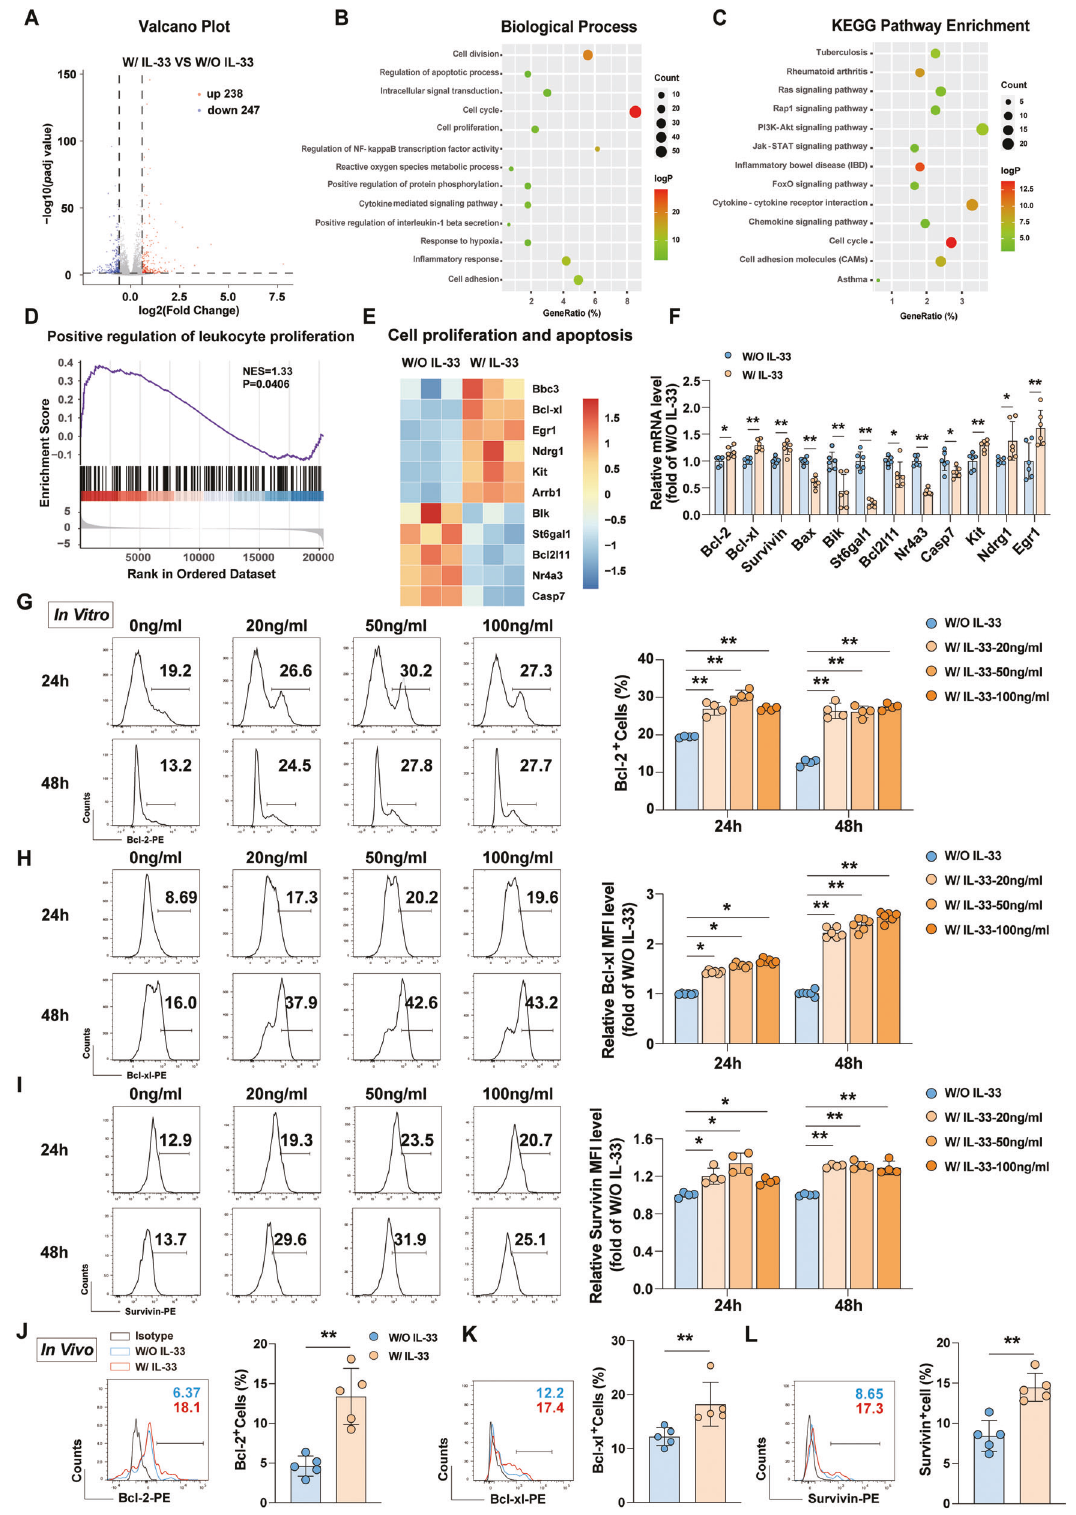
(Figs. 1A and S2A), and the apoptosis and proliferation were revealed by Annexin V and Ki67 staining at 24 h and 48 h, respectively. After optimal exogenous IL-33 stimulation (20, 50, and 100 ng/ml), cleaved caspase-3 expression and apoptosis of DNT cells were decreased (Figs. 1B, C and S2B, C), and the